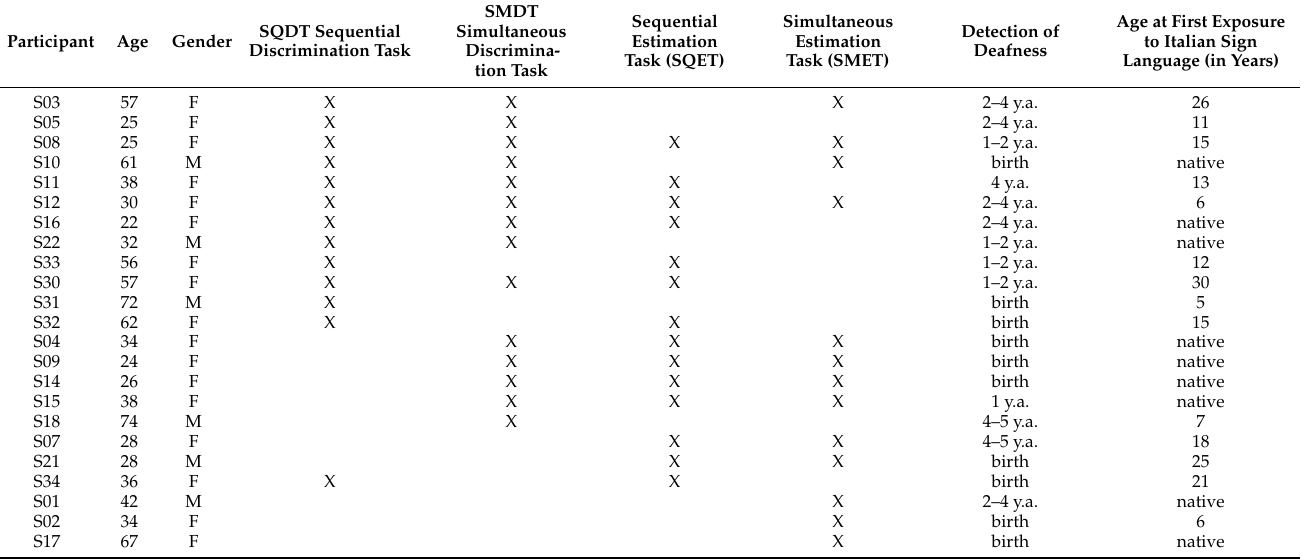
Table 2. Demographic information about deaf participants and type of task performed. SQDT = sequen- tial discrimination task; SMDT = simultaneous discrimination task; SQET = sequential estimation task; SMET = simultaneous estimation